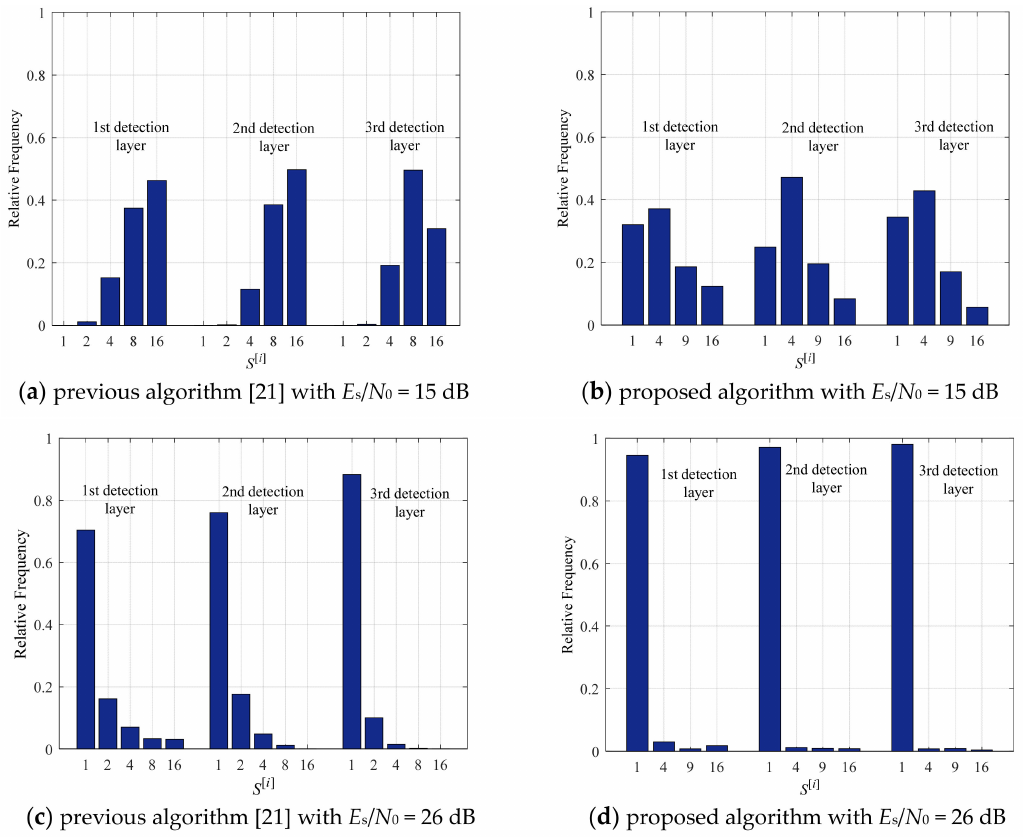
Figure 10. Relative frequencies of the conventional adaptive search area QRD -M [21] and the proposed algorithm for N = L = 4 with 16 QAM at i = 1–3 with 15 dB and 26 dB.